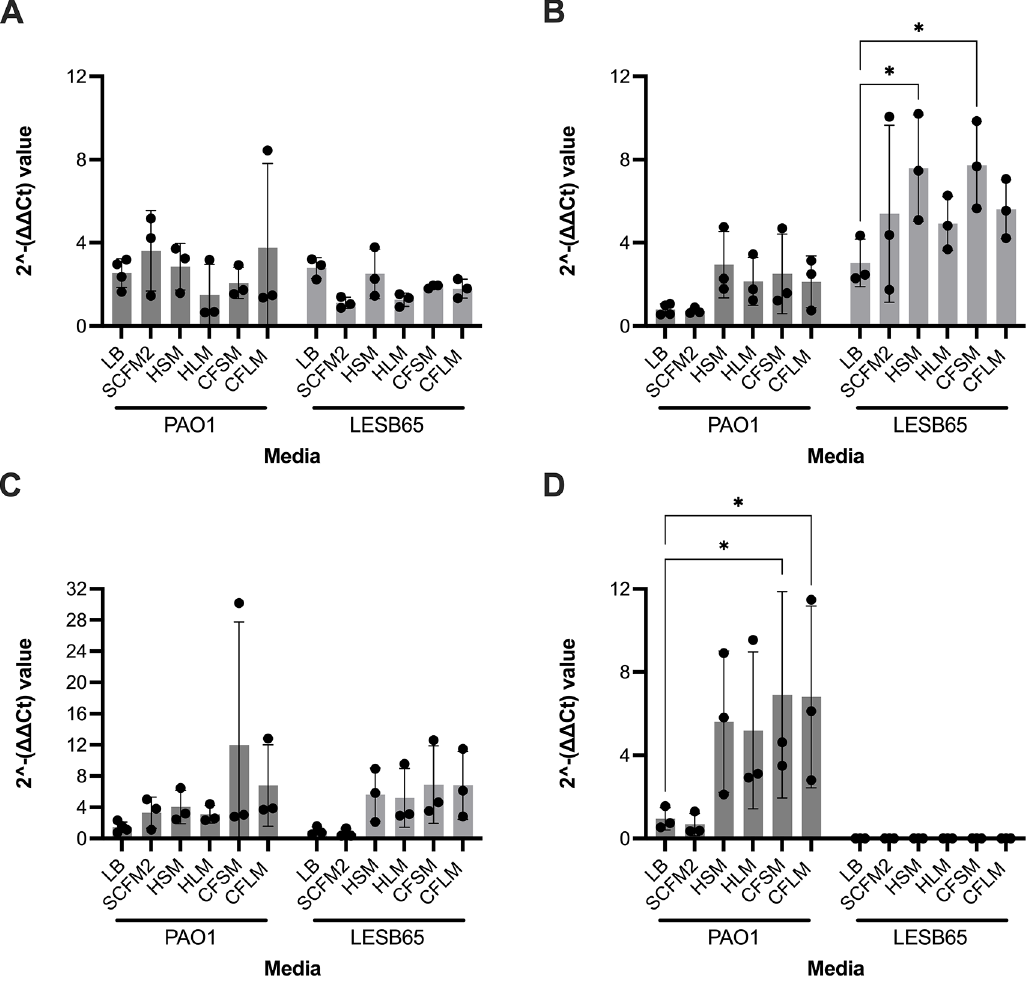
Figure 6.Expression of infection-relevant genesinrespiratory media,LBandSCFM2. Eachpoint represents one